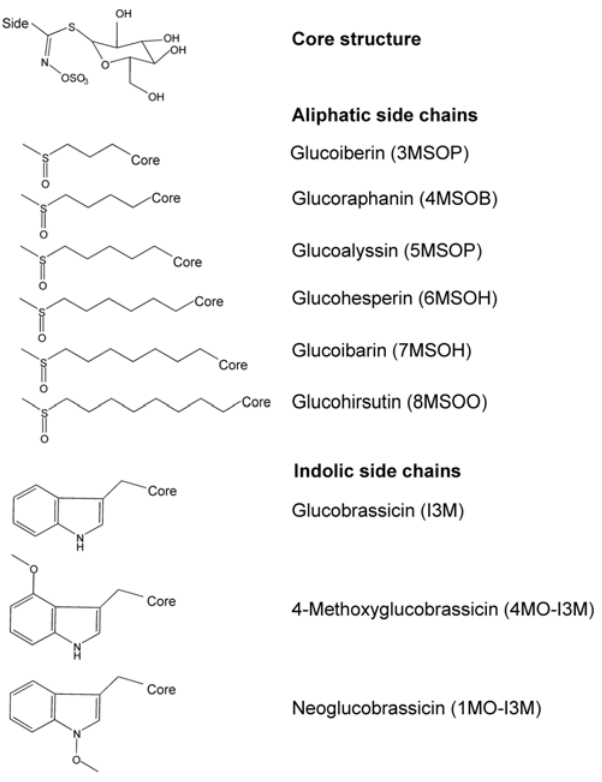
Figure 1. Chemical structures of the major glucosinolates in Arabidopsis thaliana Col-0.